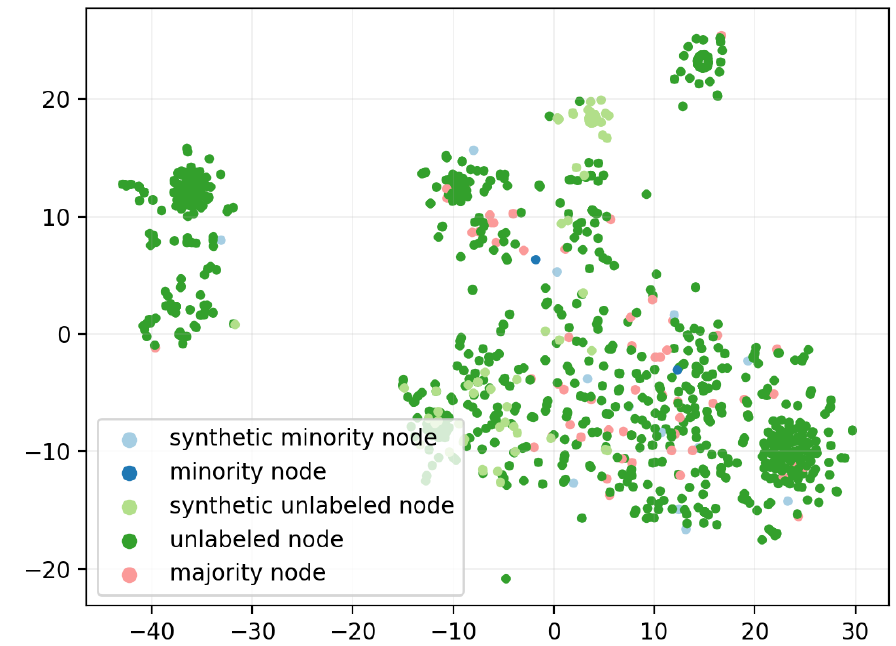
Figure 10. A t-SNE visualization of synthetic and real node features of the Y OU T UBE dataset obtained from SORAG F . The node colors denote the